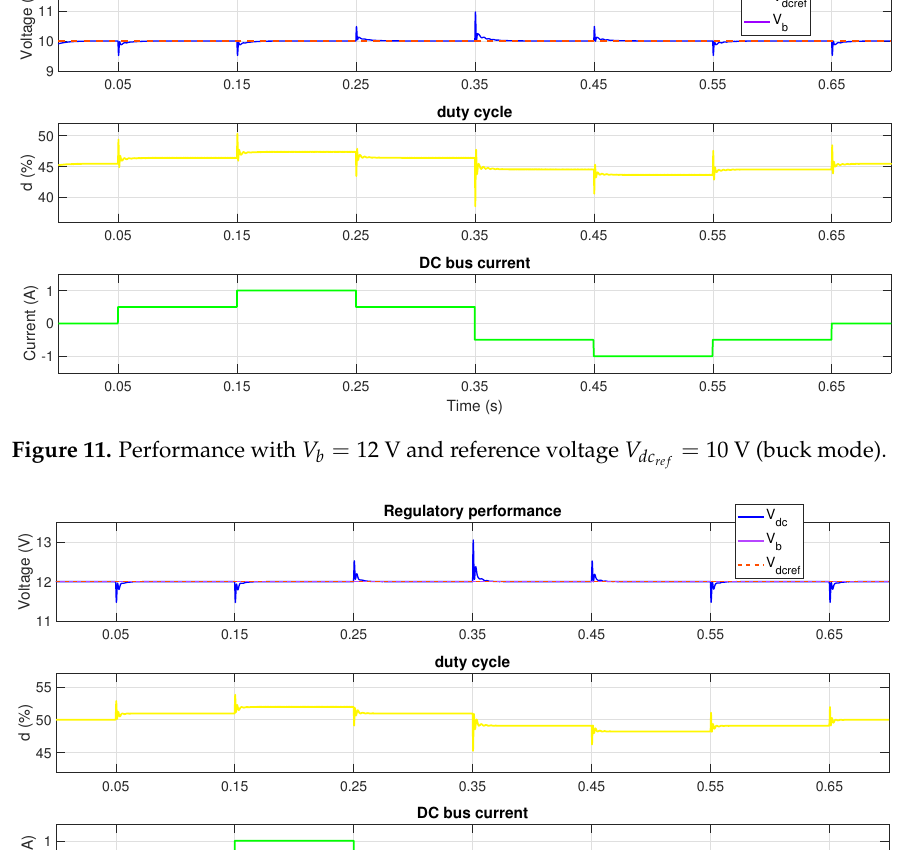
Figure 12. Performance with V b = 12 V and reference voltage V dc